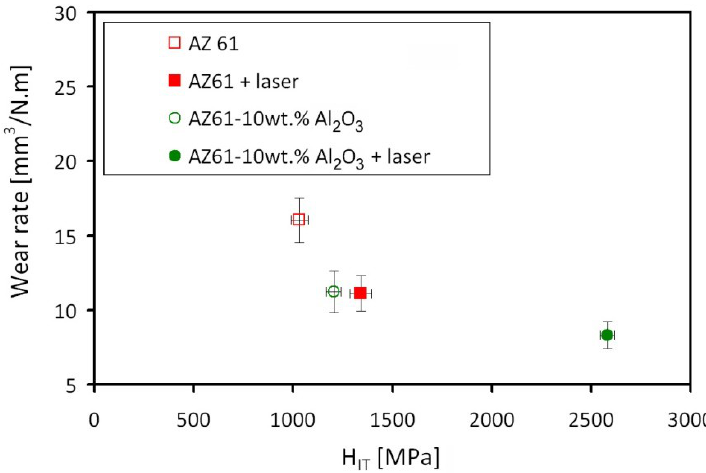
Figure 8. Correlation between indentation hardness and specific wear rate of studied materials.